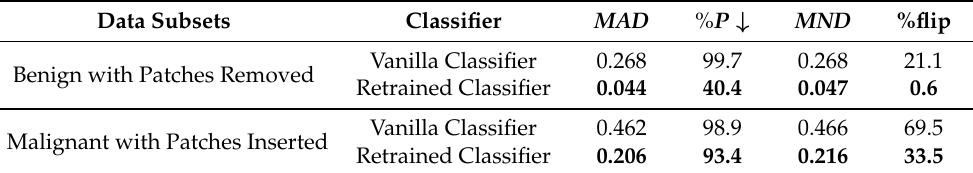
Table 3. Quantification of learned shortcuts on the test set for the original classifier (“Vanilla”) and the retrained classifier trained on the training set where coloured patches are inpainted (“Retrained”). MAD : mean absolute deviation of predictions after removing resp. inserting patches. % P ↓ : fraction of images where probability of true class decreases. MND : mean negative deviation. %flip: fraction of images where the prediction after removal/insertion crossed the decision boundary. Lower is better for all metrics. Data Subsets Classifier